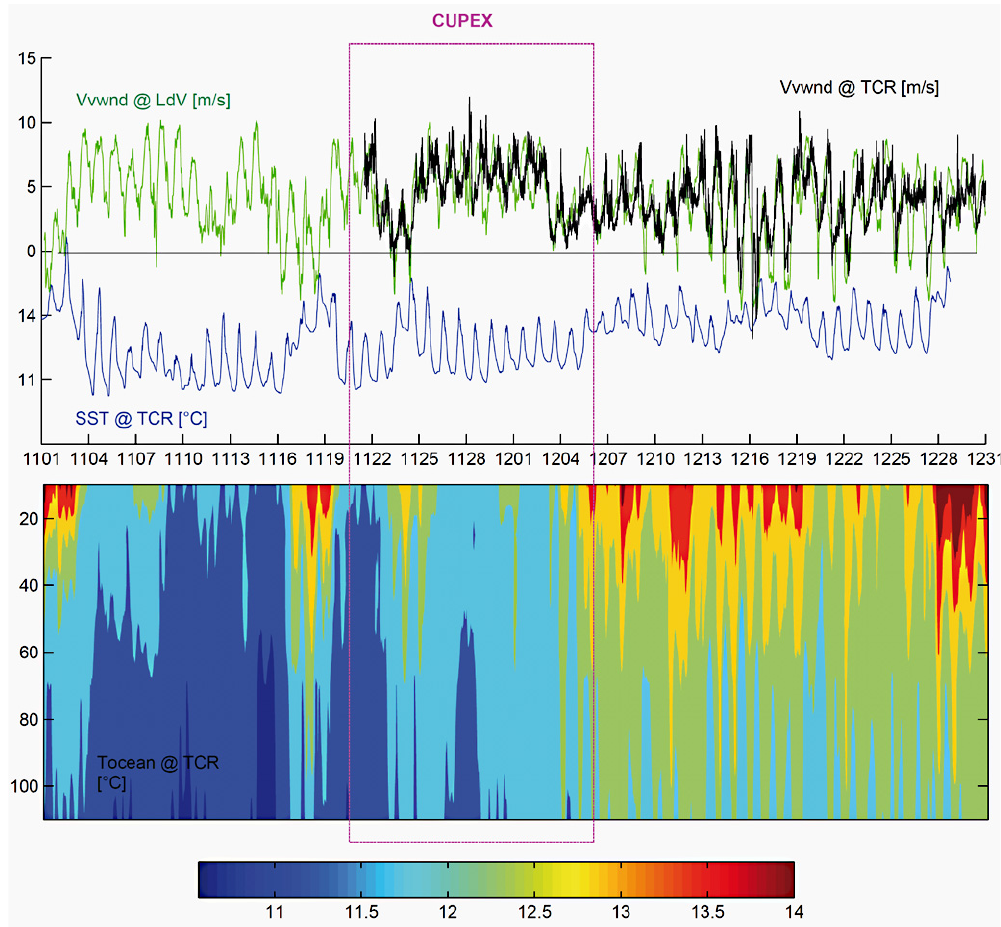
Fig. 9. Lower panel: time-depth section of ocean temperatures (in ◦ C, scale at the bottom; time is indicated in mmdd format in the upper panel) recorded by the mooring 2.2km off Talcaruca during November–December 2009. The CUpEx period is indicated by the magenta rectangle. The temperature is measured every hour at 5, 10, 15, 20, 25, 30, 40, 50, 70, 90 and 110m. Upper panel: time series of meriodional wind at point Lengua de Vaca (green line) and Talcaruca (black line), and shore SST at Talcaruca (blue